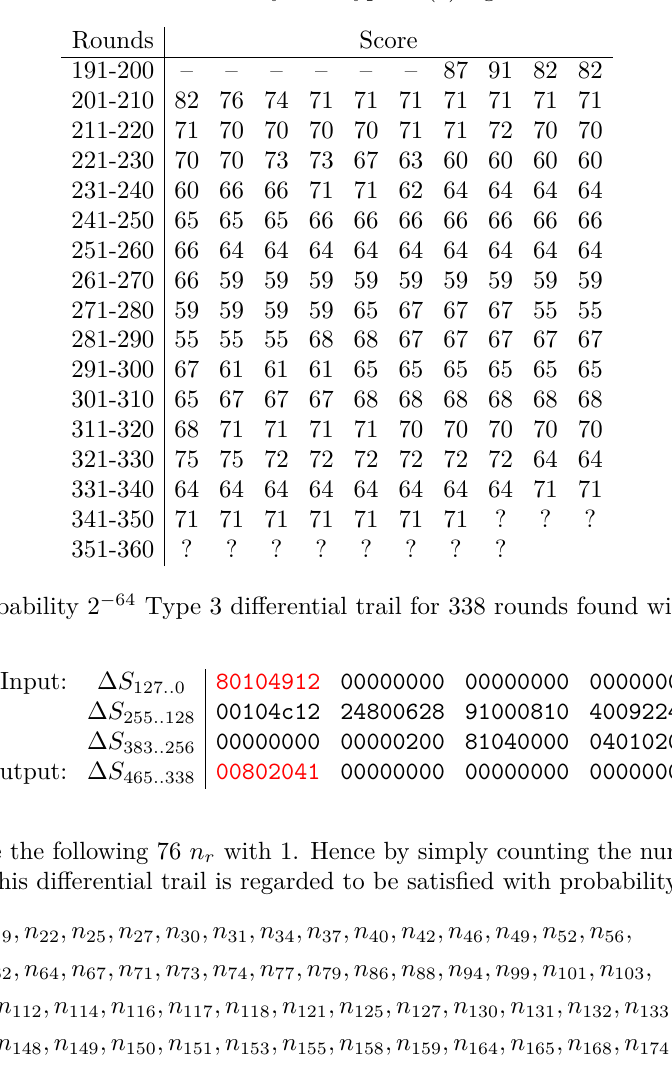
Table 6: Score of the best trail found for various number of rounds in the refined model. ‘weight’ is defined as a number of active AND gates and ‘score’ is defined as weight minus the number of correlated AND gates. Question mark (?) signifies that the solver did not finish but the score is lower bounded by 67. Hyphen (–) signifies that no valid trail exists.